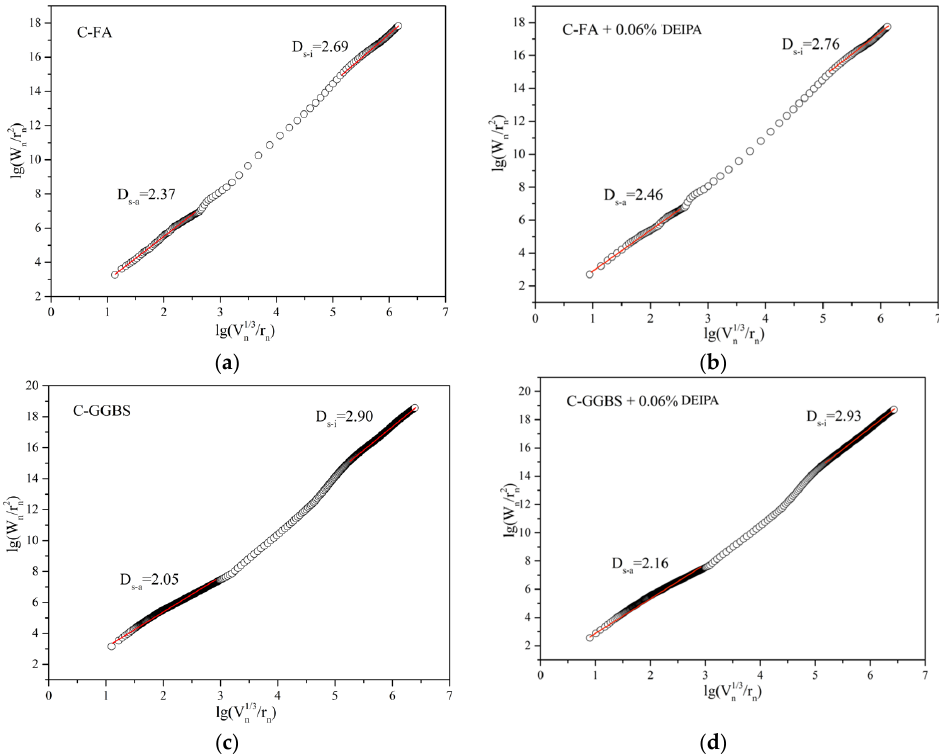
Figure 10. Logarithm plots of W n /r n2 versus V n1/3 /r n of C-FA/GGBS systems at 7 d, ( a ) C-FA, ( b ) C-FA with 0.06% DEIPA, ( c ) C-GGBS, ( d ) C-GGBS with 0.06% DEIPA. Materials 2020 , 13 , x FOR PEER REVIEW